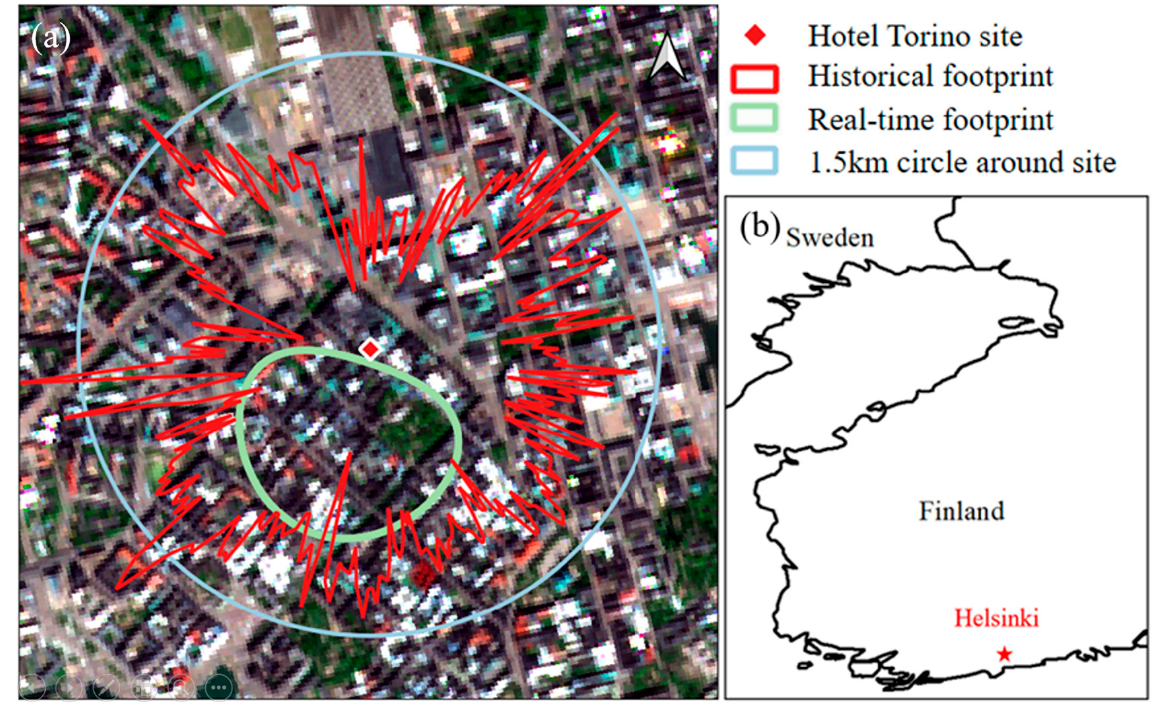
Figure 4. Maps showing ( a ) an S2 L2A bottom-of-atmospheric true color RGB image of the Hotel Torino site with three different source areas and ( b ) the location of the study flux site. The 90% footprint likelihood source area of observations was at 10:00 on 24 July 2018, and the historical footprint source area was derived from the maximum 70% footprint likelihood during the study period.